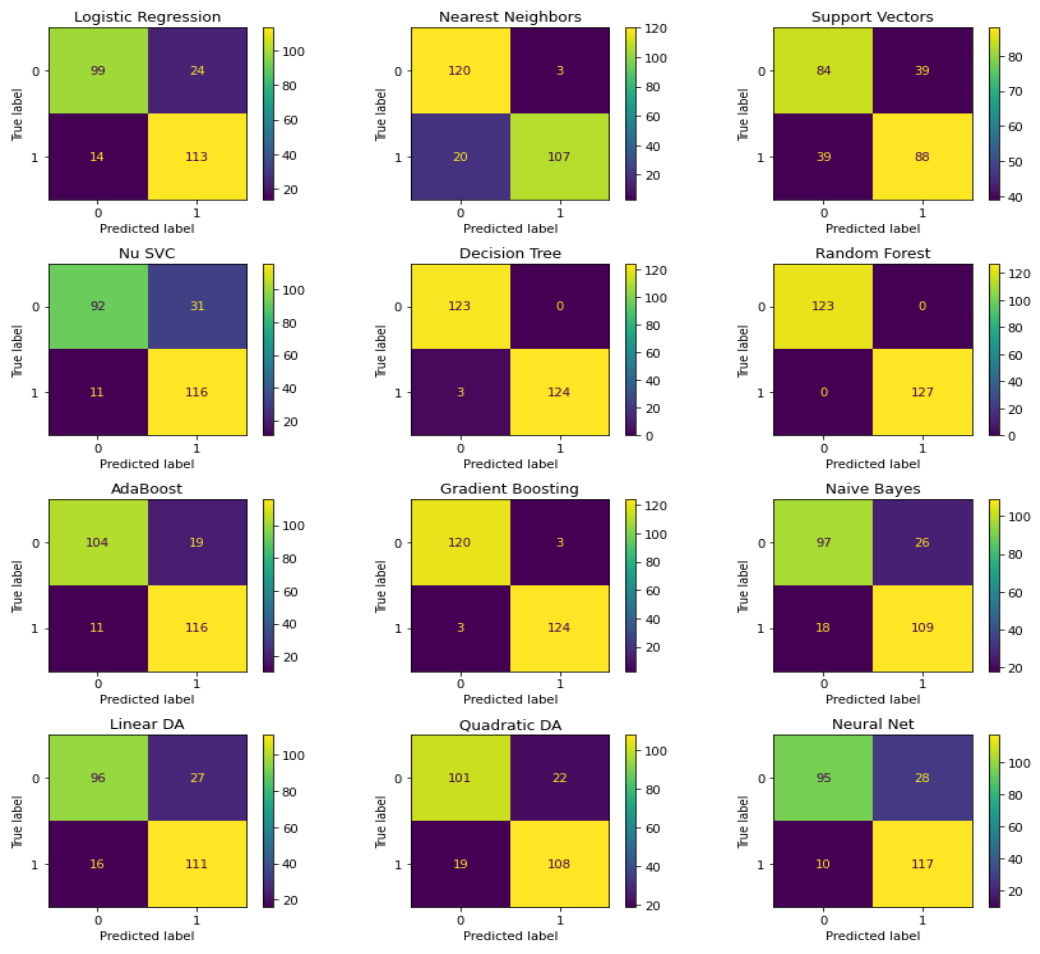
Figure 16. The confusion matrix of the predicted results.